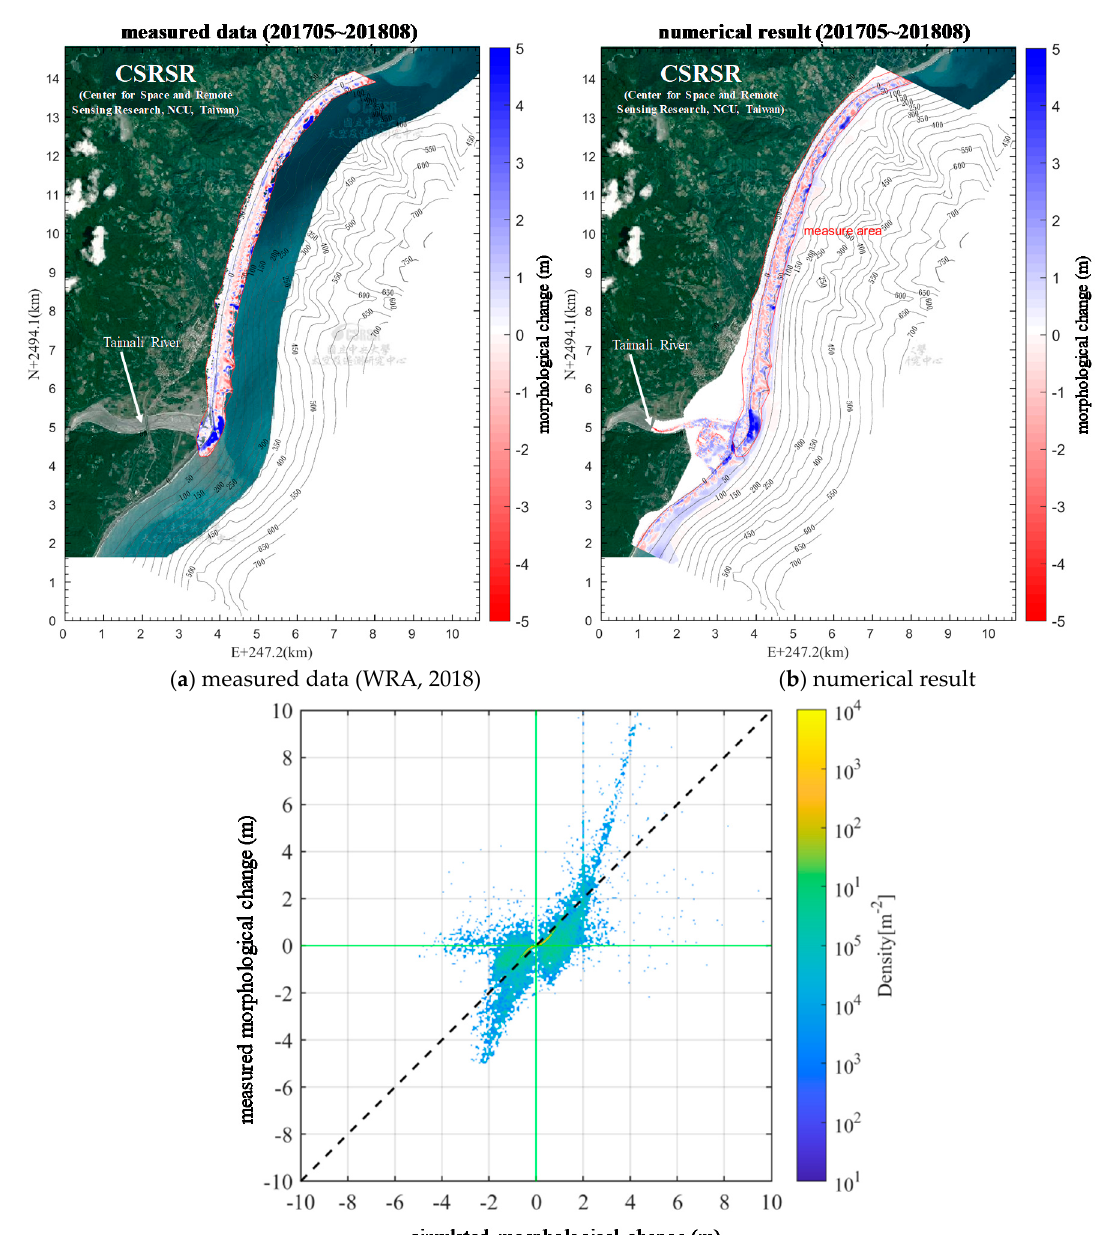
Figure 14. Comparison of morphological change between measured data and numerical result in the Taimali River mouth. ( a ) measured data (WRA, 2018); ( b ) numerical result; ( c ) quantitative comparison between measured data and simulated result.